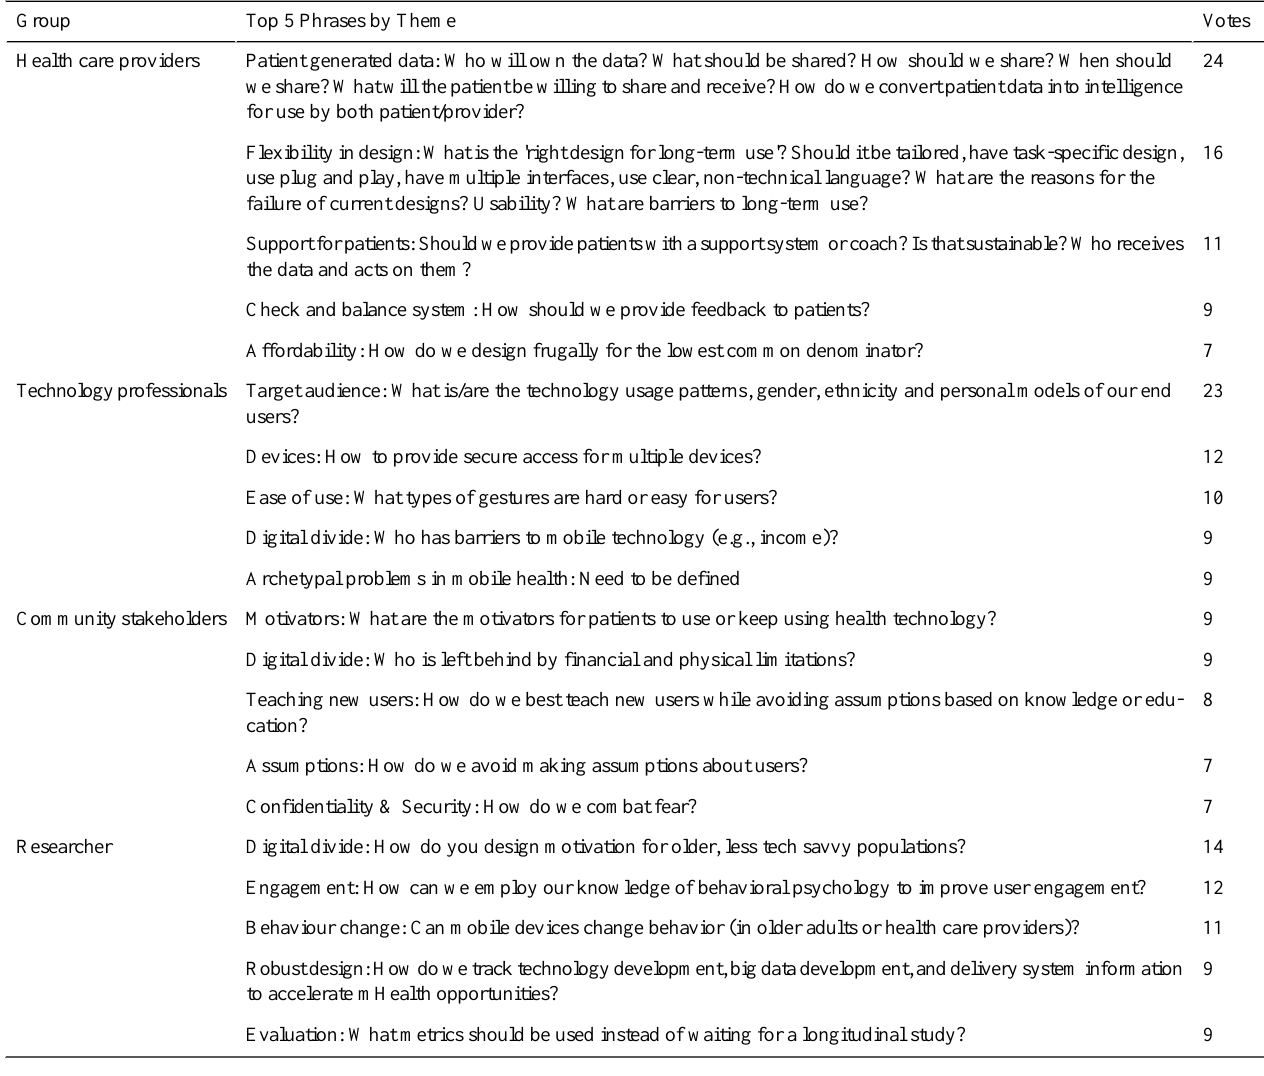
Table 3. Stakeholder perceptions of the research that needs to be done to better understand the effectiveness, usability and design of mHealth for older adults. VotesTop 5 Phrases by